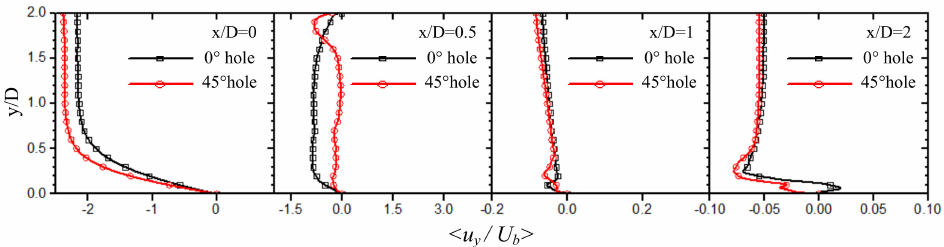
Figure 13. The distribution of axial time-averaged velocity at different